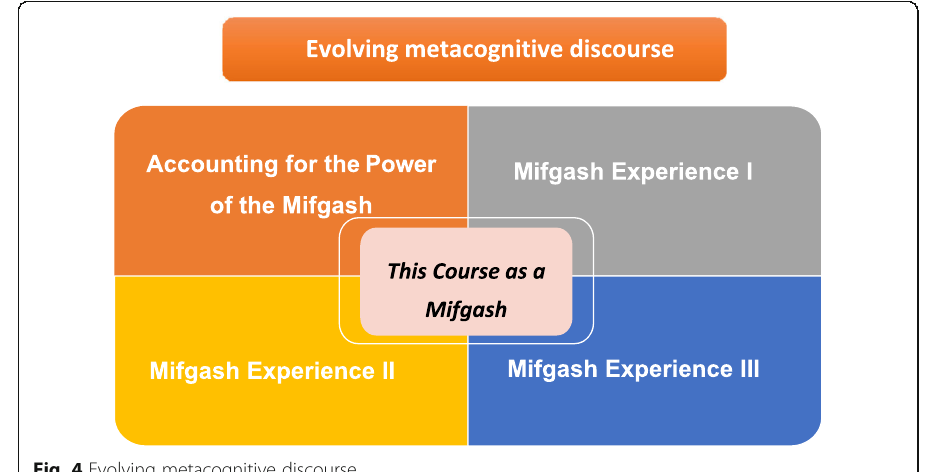
Fig. 4 Evolving metacognitive